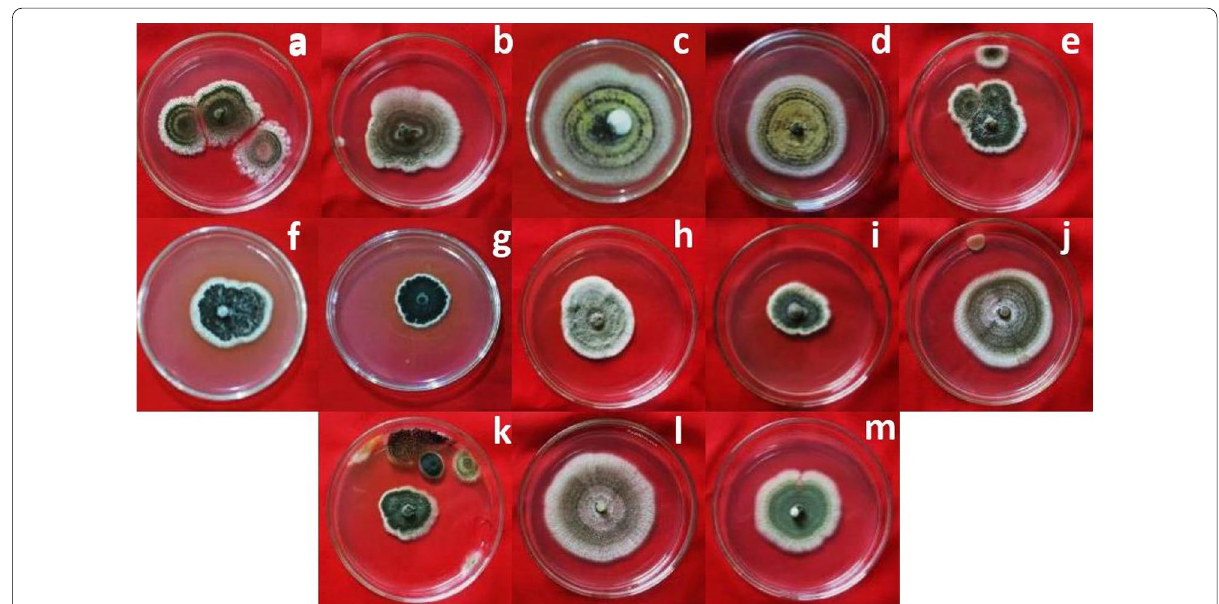
Fig. 1 Colonial morphology of Metarhizium isolates cultured in potato dextrose agar. a MaBe, b MaBl, c MaBt, d MaBo, e MaJe, f MaKa, g MaLe, h